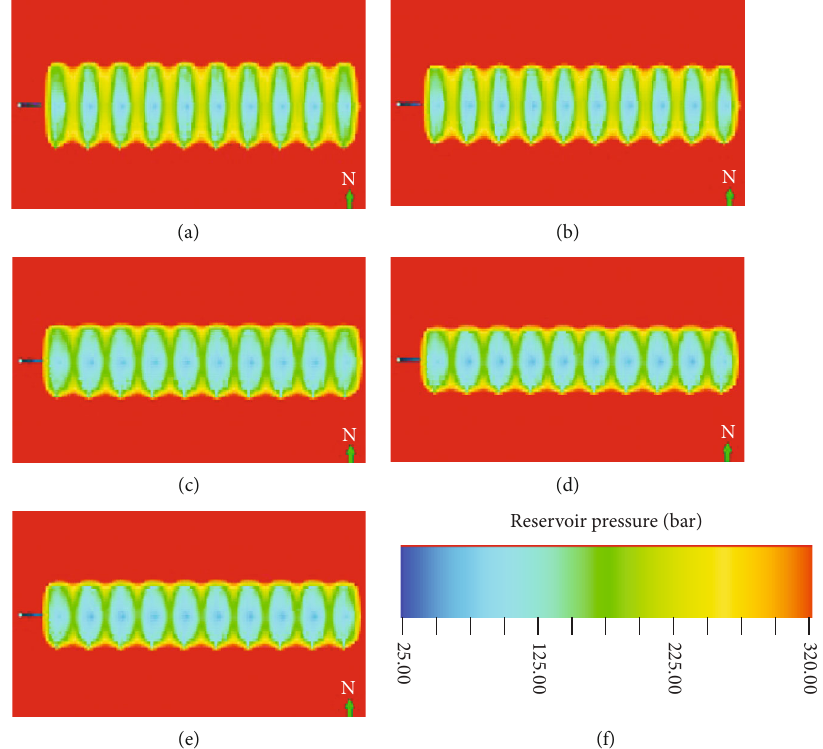
Figure 4: Pressure drop at the end of production with di ff erent Young ’ s moduli: (a) Young ’ s modulus is 2GPa, (b) Young ’ s modulus is 4 GPa, (c) Young ’ s modulus is 6 GPa, (d) when Young ’ s modulus is 8 GPa, (e) Young ’ s modulus is 10 GPa, and (f) the legend of reservoir